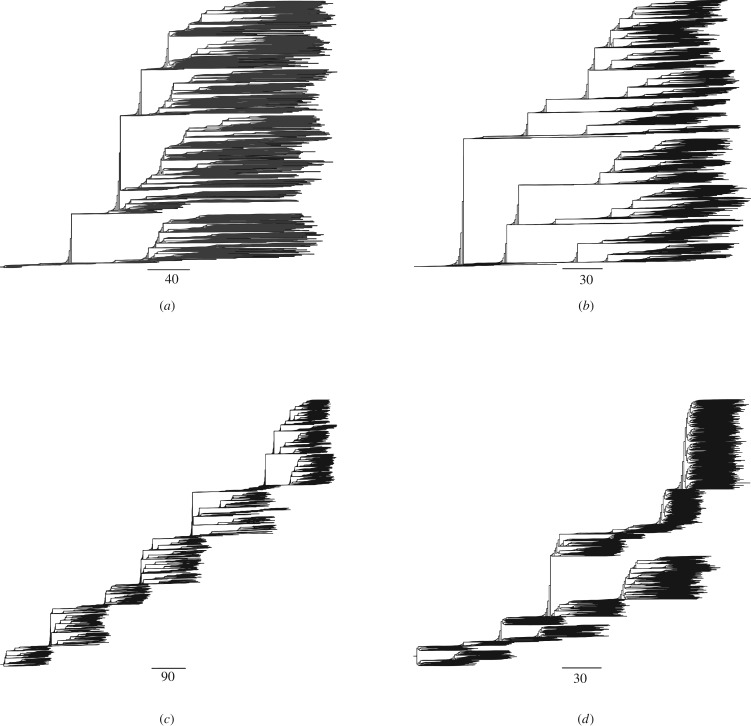
Cancer phylogenies under directionally changing TME selection dynamics. These results demonstrate that it is possible to use cancer phylogenies to understand the underlying TME selection dynamics due to either cancer treatments or somatic evolution. Example phylogenies are shown for simulated cancers under three different TME selective dynamics. (a–d) Four illustrative phylogenies are shown for a directionally changing TME optimum with four different speeds: v1 = 0 (static TME) (a), v1 = 5 × 10−5 (b), v1 = 5 × 10−4 (c) and v1 = 5 × 10−3 (d). All cancers were longitudinally sampled for every 100 generations for a fixed period of 10 000 generations except (d), where the cancer went extinct at approximately 2300 generations. The maximum population size is set at n = 105. The scale bar represents the number of cell divisions.